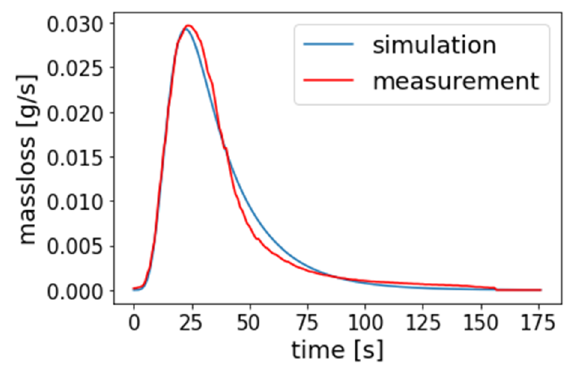
Figure 5. Comparison of the measured and simulated mass loss of three pellets with a total weight of 1 g, temperature combustion chamber 800 ◦ C, primary air flow 0.2 g/s and secondary air flow of 1 g, temperature combustion chamber 800 °C, primary air flow 0.2 g/s and secondary air flow 0.15 g/s. 0.15